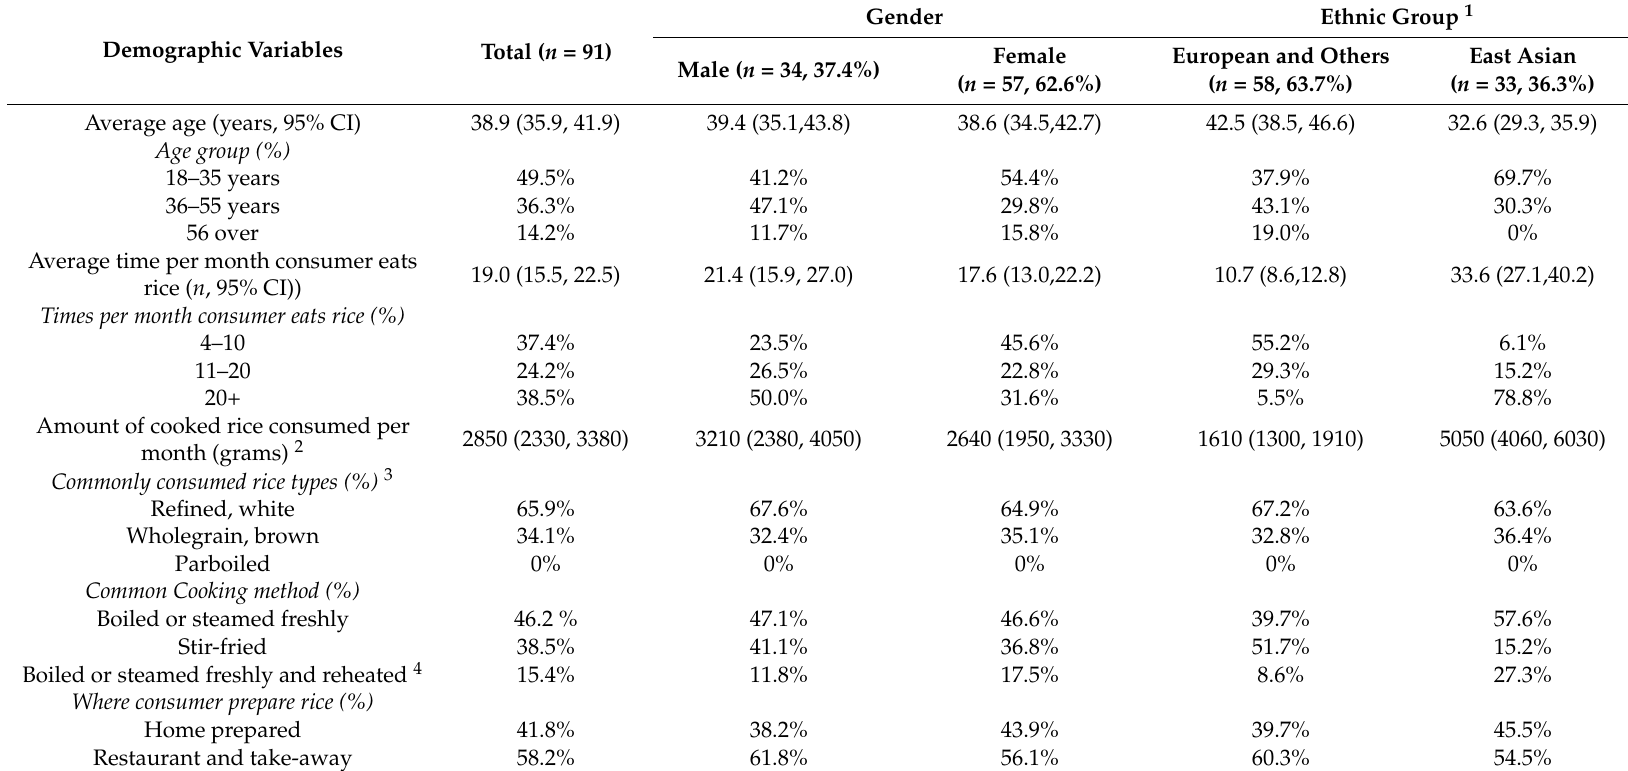
Table 1. Demographics of interviewed rice consumers ( n = 91) at Auckland Akoranga (Northshore area) and city centre area.